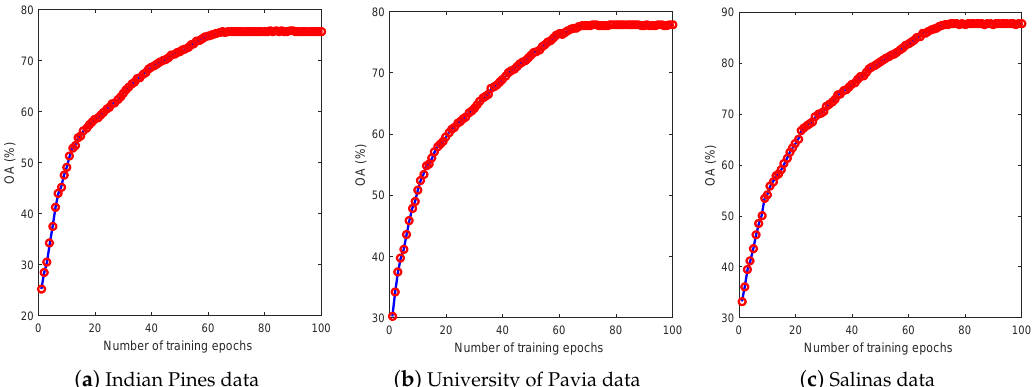
Figure 15. The impact of training epoch on the OA in ( a ) Indian Pines data, ( b ) University of Pavia data and ( c ) Salinas data.